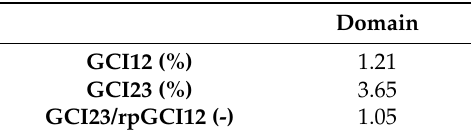
Table 8. Grid Convergence Index (GCI)